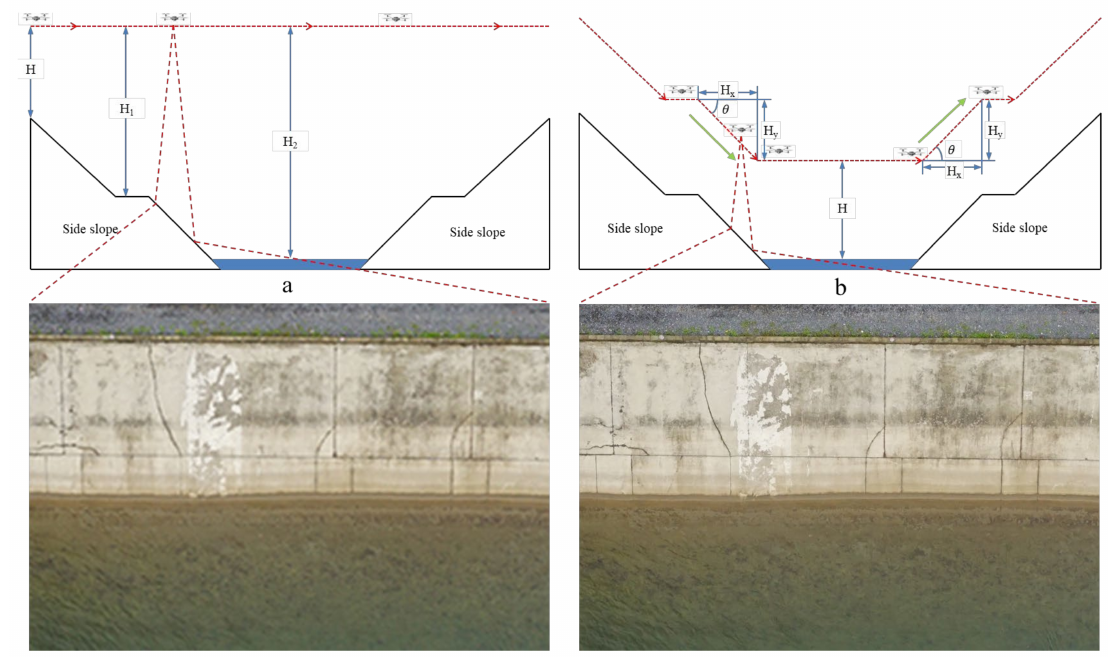
Figure 2. Ground-imitating and fixed high-flight acquisition images. Ground-imitating flying, also known as terrain following, means that the UAV main- tains a fixed relative height difference between the route and the 3D terrain in real time during the aerial-survey operation. This type of aerial flight makes it possible to keep the image ground resolution unaffected by terrain changes by adjusting the route with the terrain changes. The use of ground-imitating flying photogrammetry technology requires a DSM database with a certain level of accuracy before accurate ground-mimicking can be carried out. Therefore, this study uses the DJI Phantom 4RTK UAV to collect DSM terrain data in the survey area using a fixed altitude flight method, with the flight altitude set to 80 m and the heading overlap and the side overlap both set to 75%. The DSM file of the test area was obtained after data processing, as shown in Figure